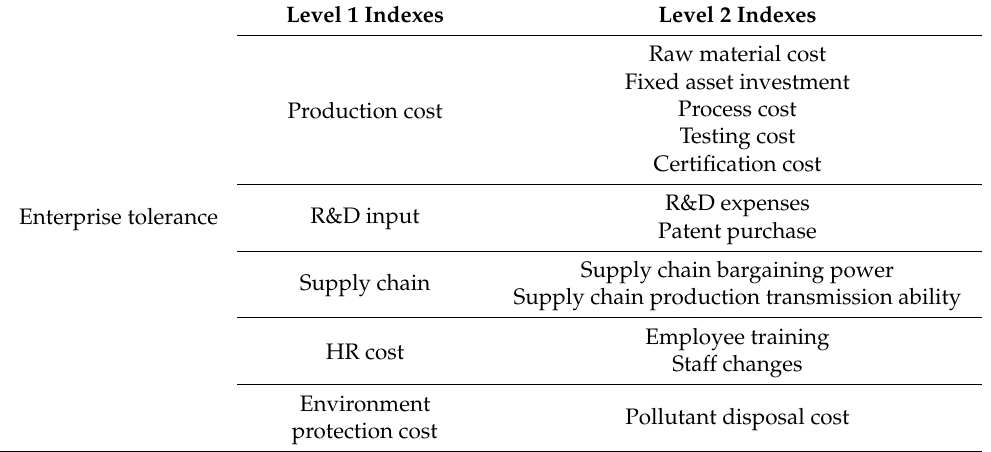
Table 1. Enterprise chemical limit tolerance evaluation index